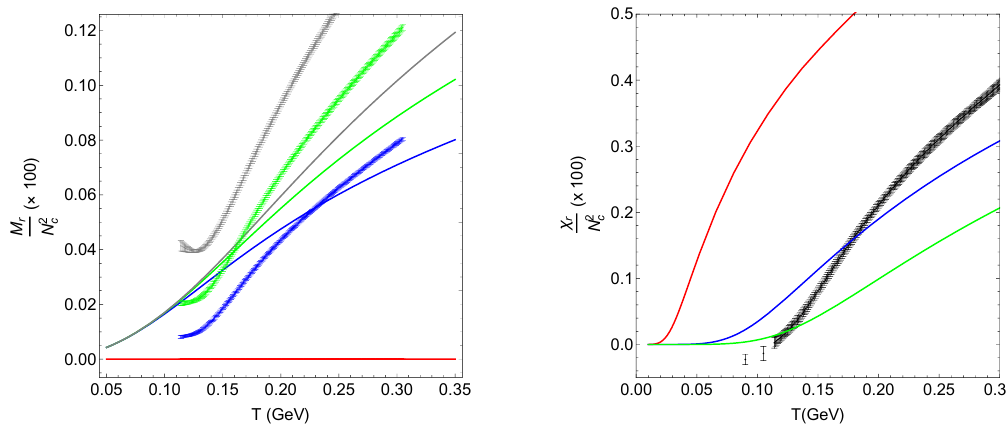
Figure 11 . Left panel: magnetisation density M r , divided by N 2 (solid lines), compared with lattice results (dots with error bars), divided by N 2 of the magnetic field. The red, blue, green and gray lines correspond to B = 0 GeV 2 , B = 0 . 2 GeV 2 , B = 0 . 3 GeV 2 and B = 0 . 4 GeV 2 . Right panel: magnetic susceptibility χ r , divided by N 2 function of temperature, compared with lattice results, divided by N 2 magnetic field. The red, blue and green lines correspond to B = 0 . 01 GeV 2 , B = 0 . 1 GeV 2 and, B = 0 . 2 GeV 2 respectively. The lattice results (black dots with error bars) were obtained in the limit B → 0